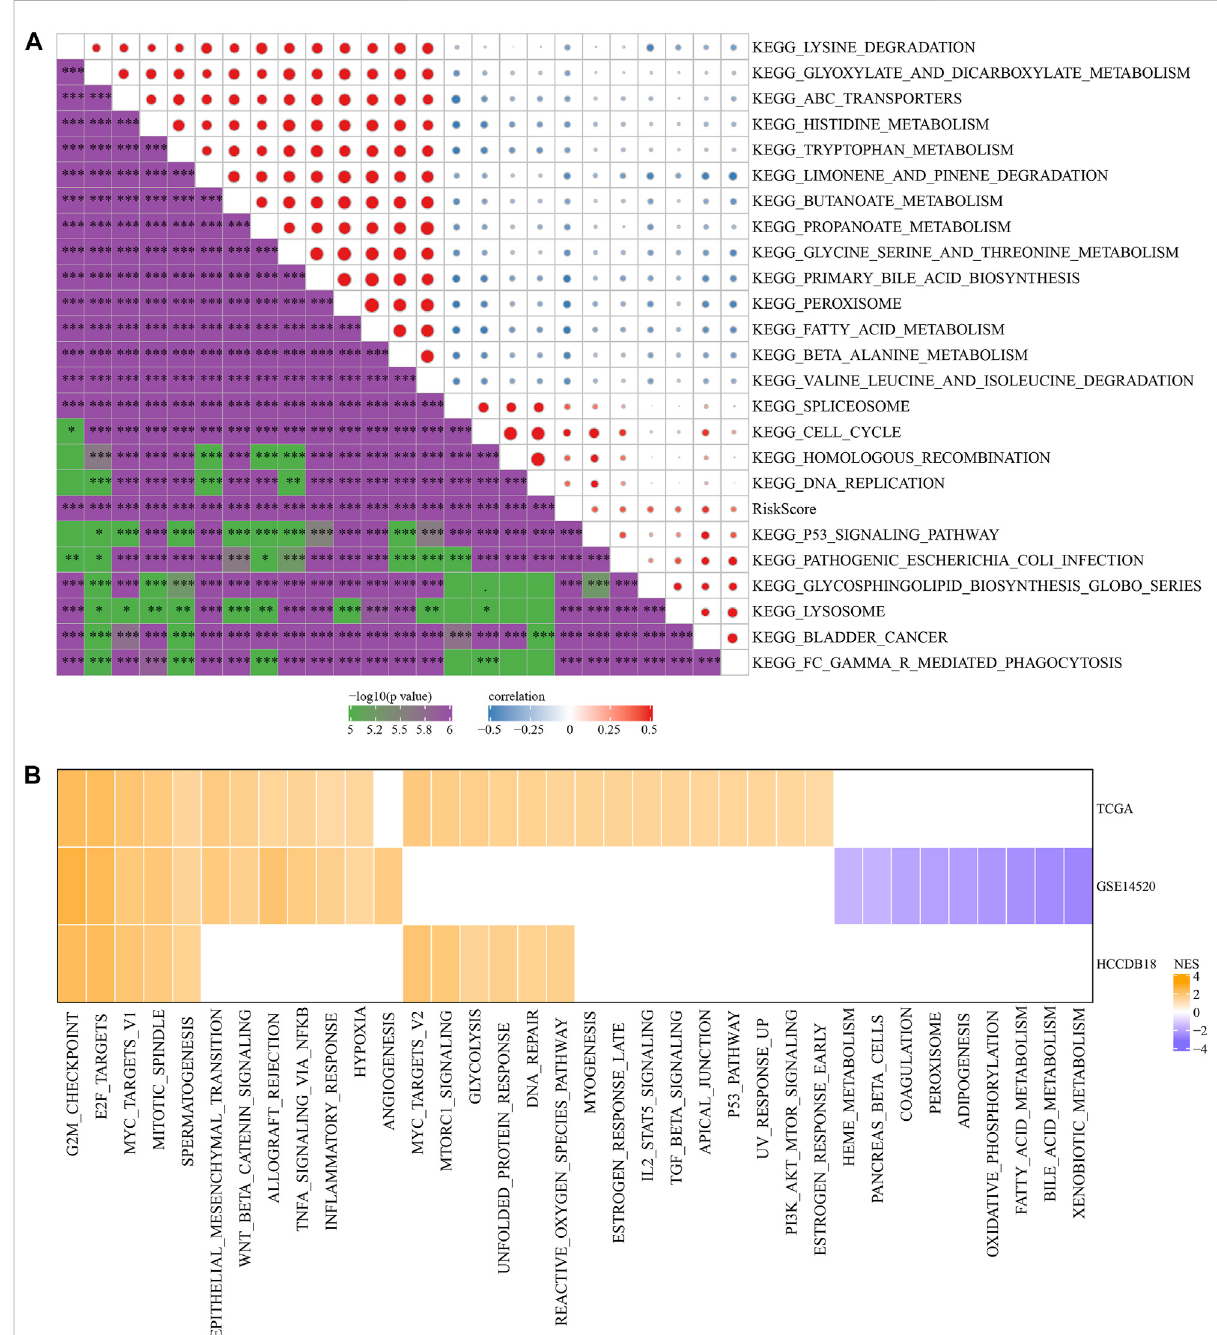
FIGURE 7 PathwaycharacteristicsbetweenRSgroups. (A) ThecorrelationanalysisresultsbetweentheKEGGpathwayandRSwhosecorrelationwithRSin TCGA cohort is greater than 0.35; (B) RS-high and RS-low enrichment fractional heat